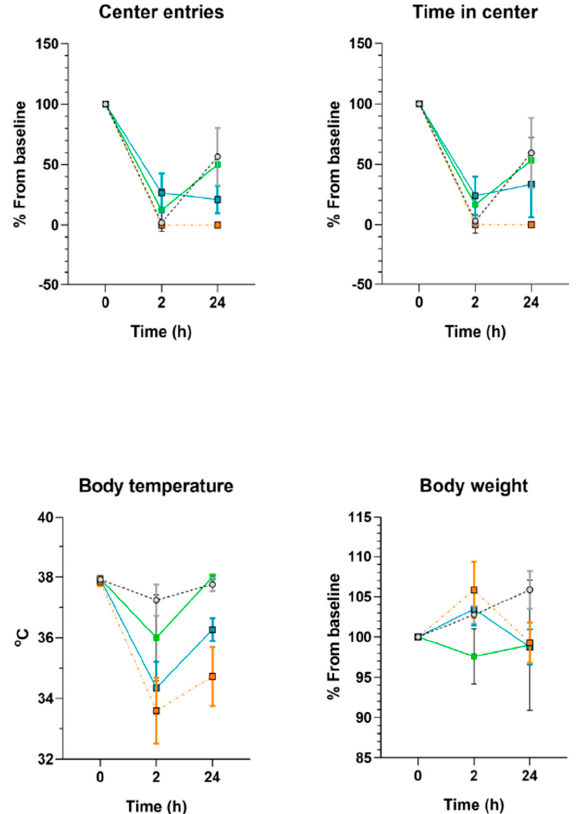
Figure 3. Exploratory activity of mice in the open field test. Data are shown as mean ± SD.